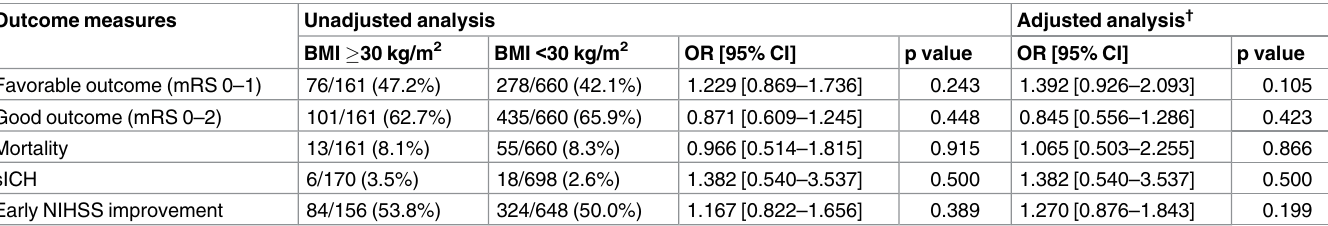
Table 1. Comparison of Outcomes in patients with BMI (cid:21) 30 kg/m 2 vs. < 30 kg/m 2 . Outcome